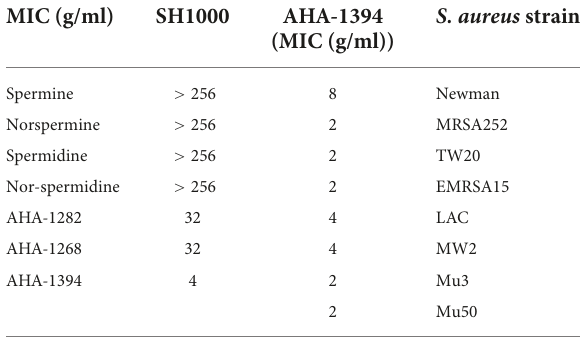
TABLE 2 Novel linear polyamines display enhanced bactericidal activity against S. aureus